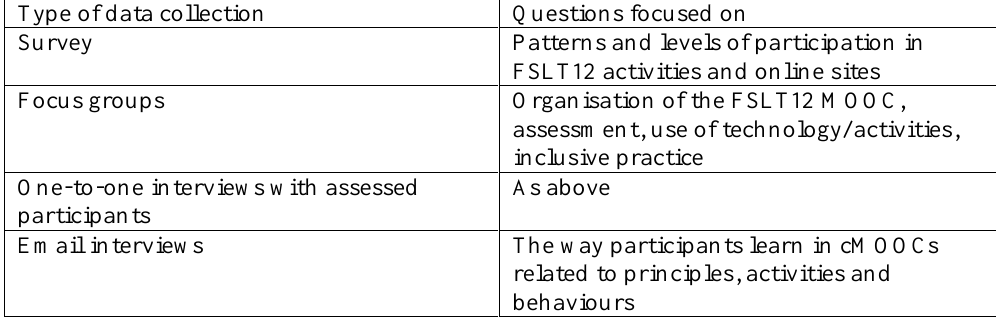
Data collection in FSLT12 Type of data